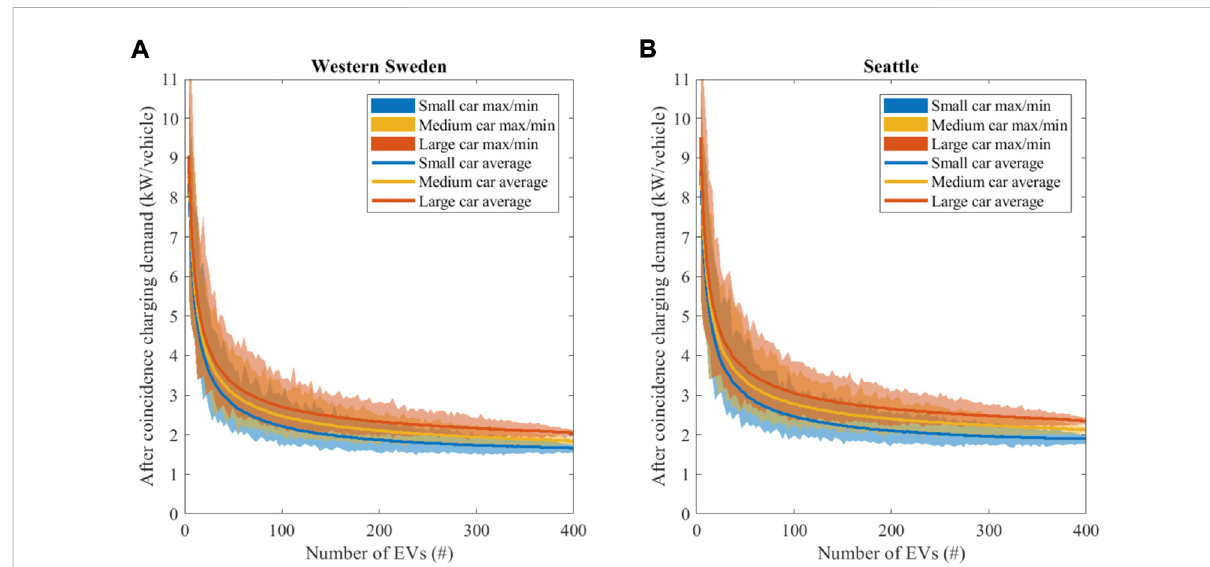
FIGURE 4 After-coincidence charging power demand for the highest hour of the year and as an average for all combination of vehicles with different driving patterns. After-coincidence charging power demand for three different sized cars. Charging location is home only and nominal charging power is 11 kW. Data for Western Sweden in (A) and Seattle (B) . Shaded areas show variation (max and min) from the randomized combinations.